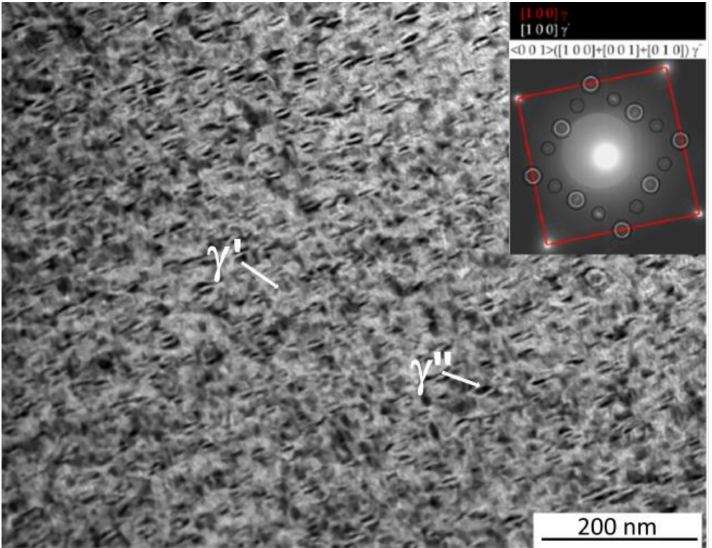
Figure 14. TEM bright field images of 1DAH sample with corresponding SAD patterns of γ and γ (cid:48)(cid:48) phases along the [112] and [111] zone axes,